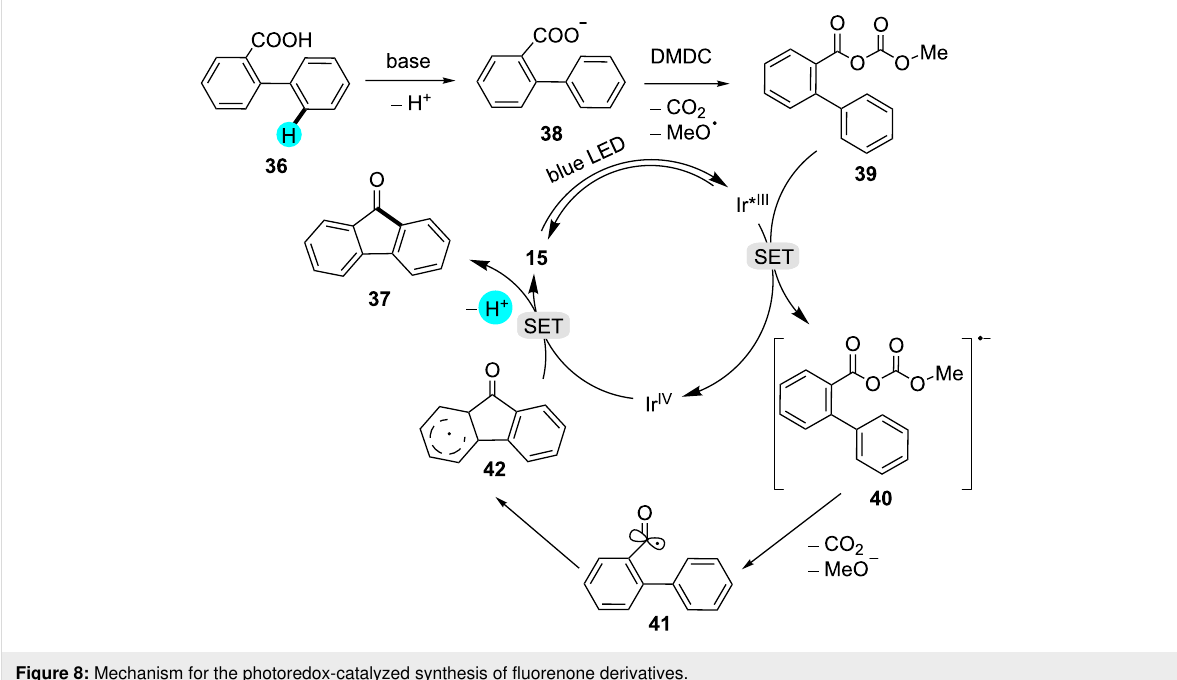
Figure 8: Mechanism for the photoredox-catalyzed synthesis of fluorenone derivatives.